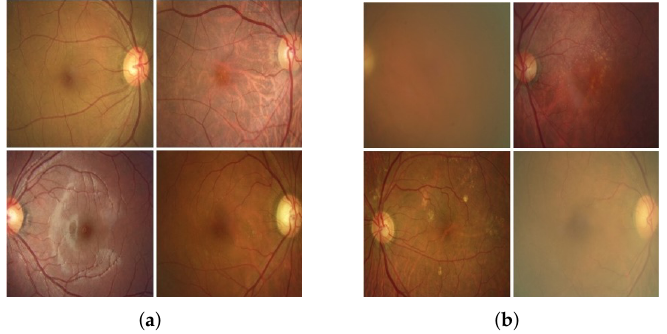
Figure 20. Examples of misclassification of Classes 3 and 4 by EfficientNet-B7. ( a ) Class 3; ( b ) Class 4.